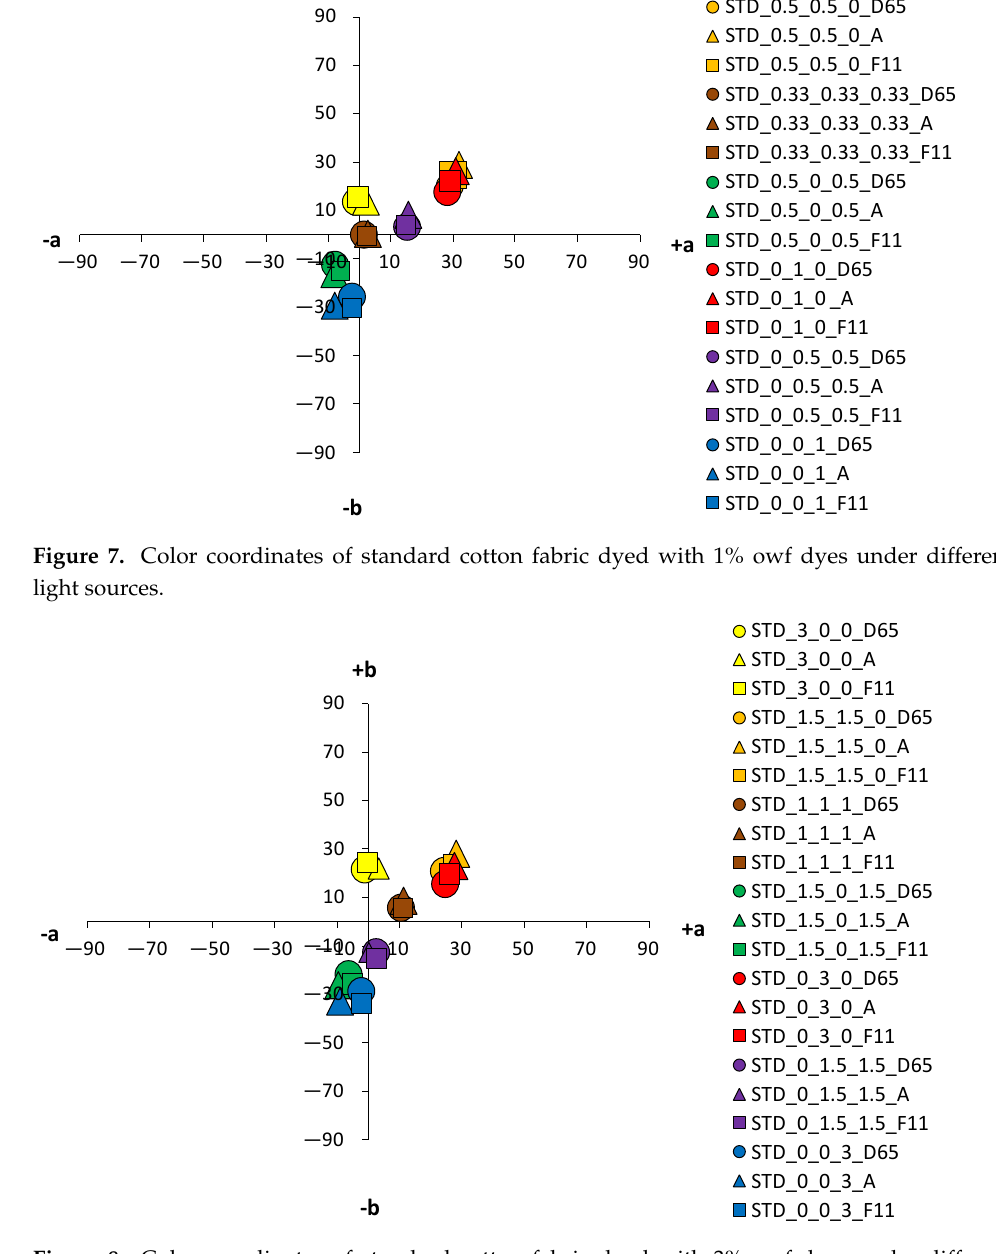
Figure 8. Color coordinates of standard cotton fabric dyed with 3% owf dyes under different light sources.